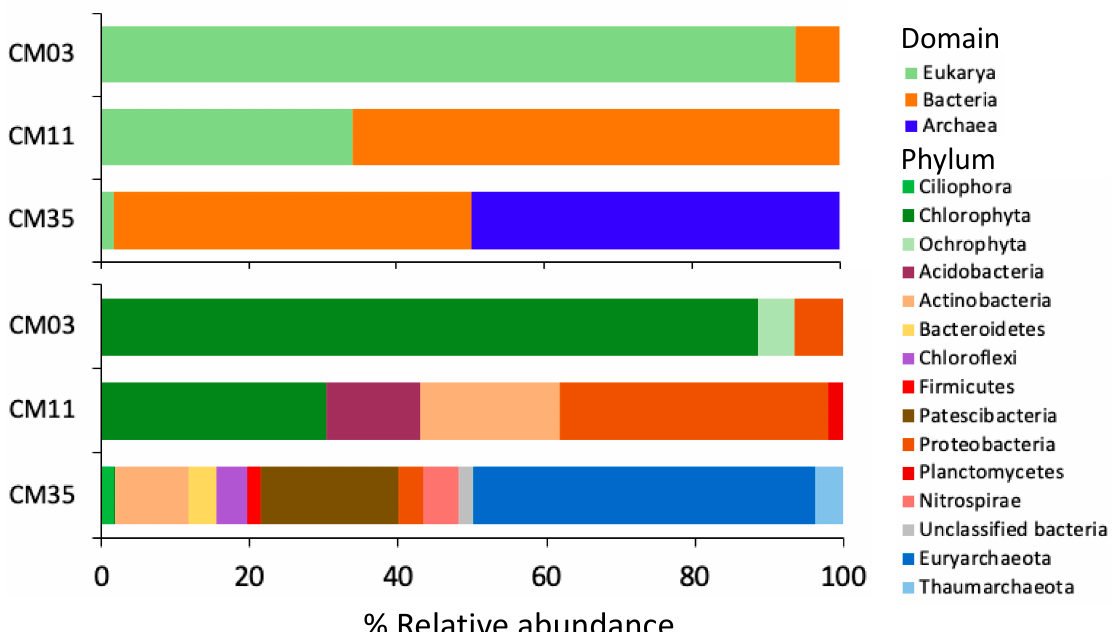
Figure 1. Taxonomy of the three layers of Cueva de la Mora (CM) at the domain (upper panel) and phylum (lower panel) levels. 16S and 18S rRNA genes were recovered from the metagenomes using EMIRGE [39] and SINA v.1.2.11 [40] for taxonomic classification.